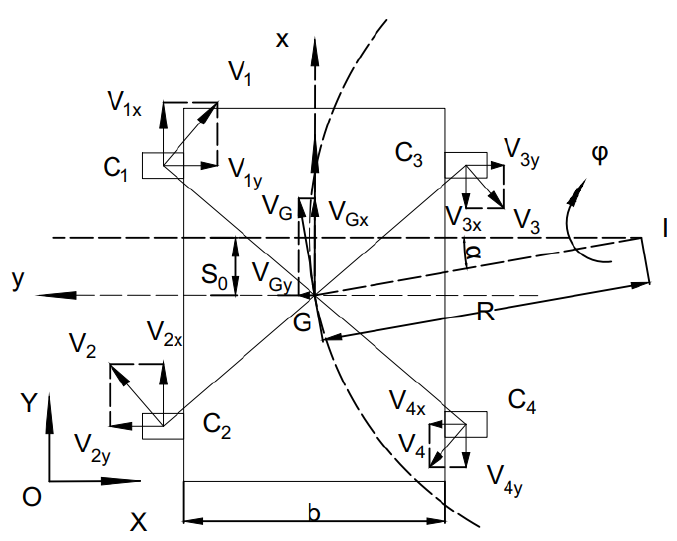
Figure 1. Kinematic Figure 1. kinematic model.